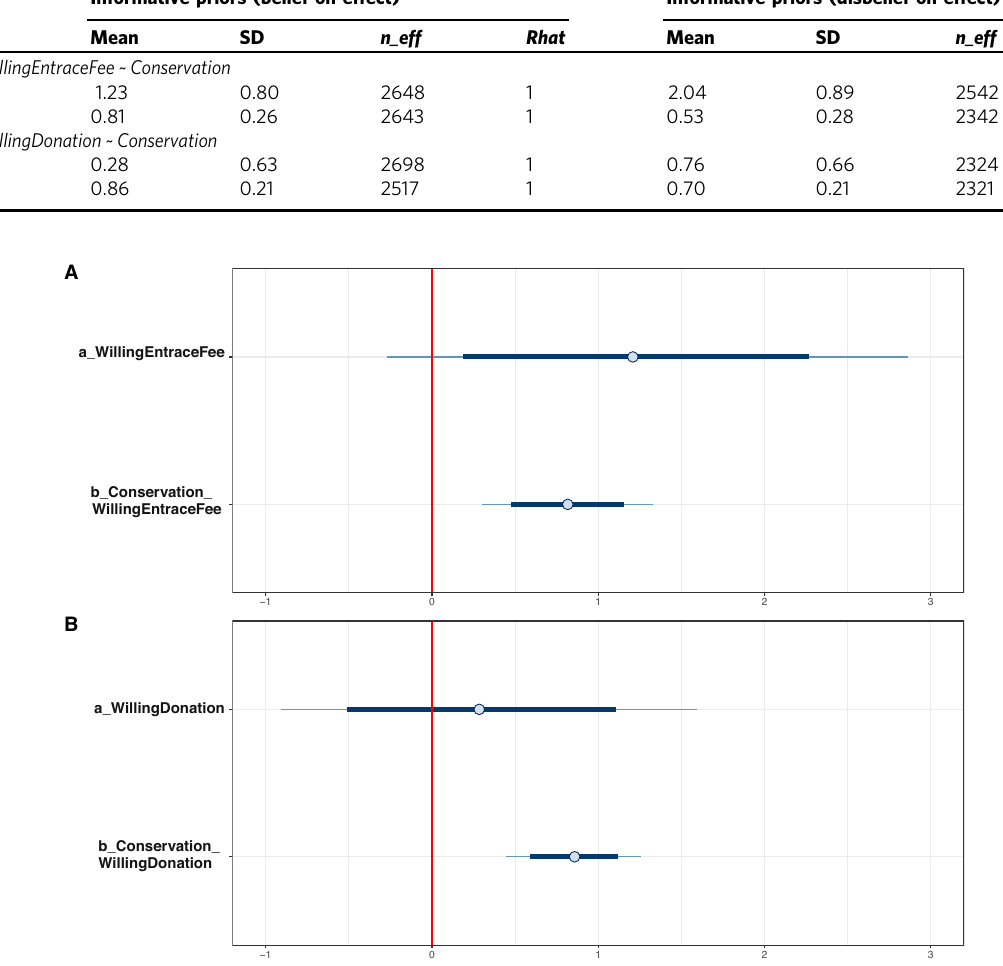
Table 3 Model 2a ’ s and Model 2b ’ s simulated posterior results. Parameters